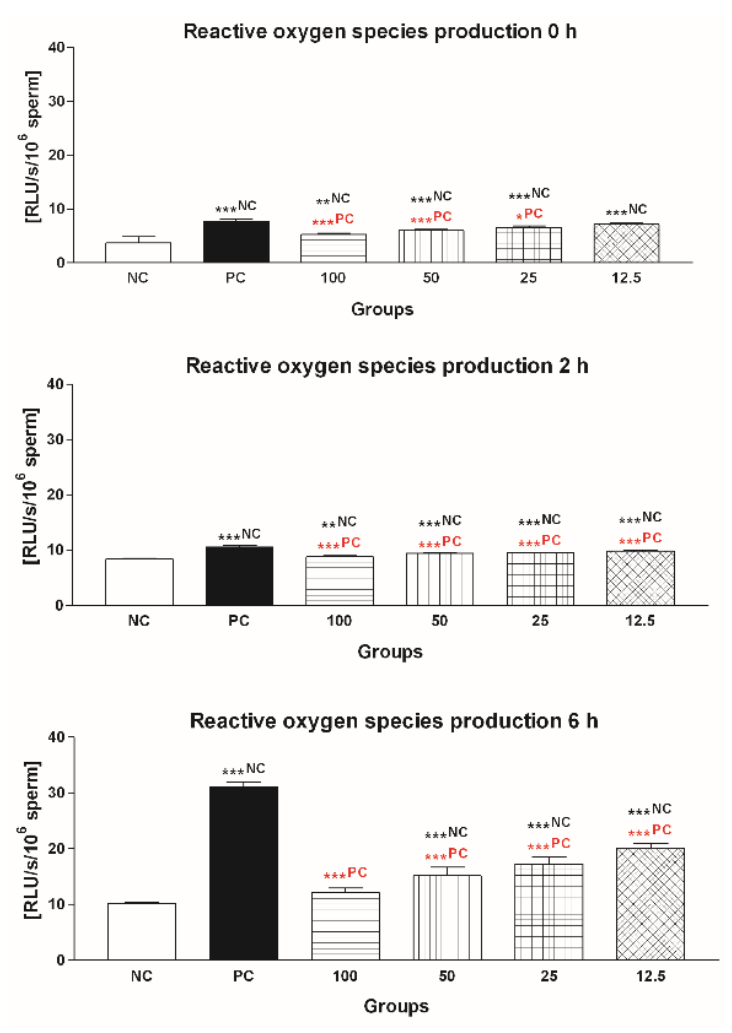
Figure 3. Reactive oxygen species (ROS) production by bovine spermatozoa exposed to four doses of epicatechin (EPI; µ mol / L) in the presence of ferrous ascorbate (FeAA). The data were obtained from five independent experiments. * p < 0.05; ** p < 0.01; *** p < 0.001. NC—vs. negative control; PC—vs. positive control.